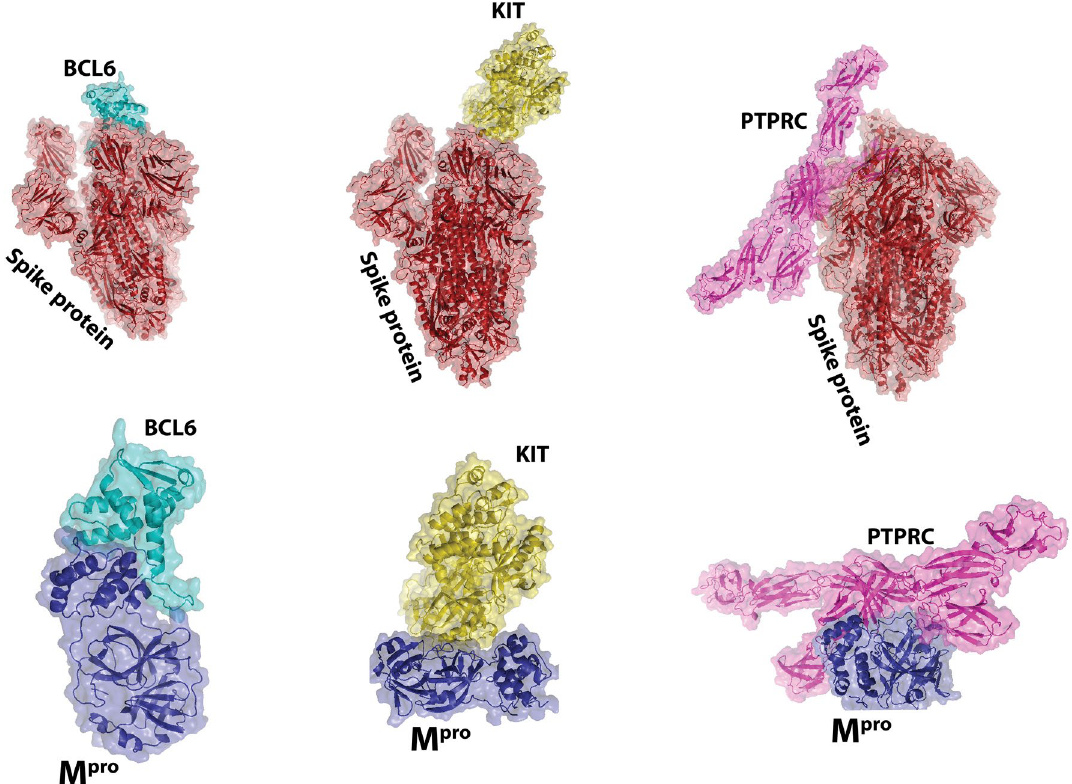
Fig. 7 Molecular docking interactions and orientations for three com- mon hub proteins in leukemia, and SARS-CoV-2 spike protein and Mpro. Docking interactions of A BCL6, B KIT, and C PTPRC. Visu-